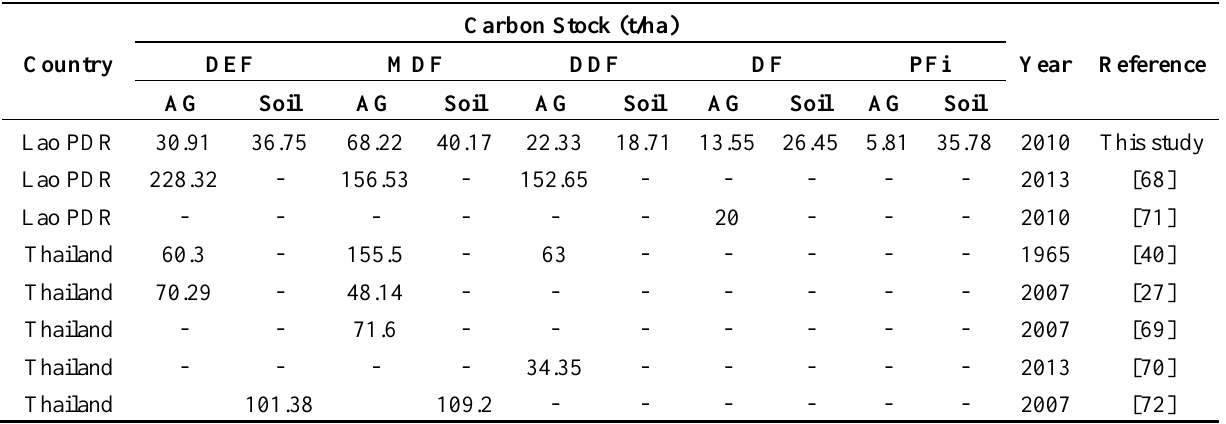
Table 8. Carbon stock values in various forest types found by this study and by previous studies. Country